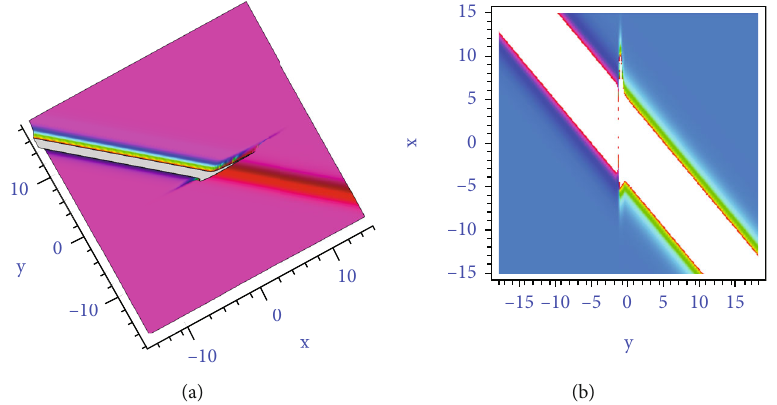
= β = 1 , σ = − 1 , k 1 1 1